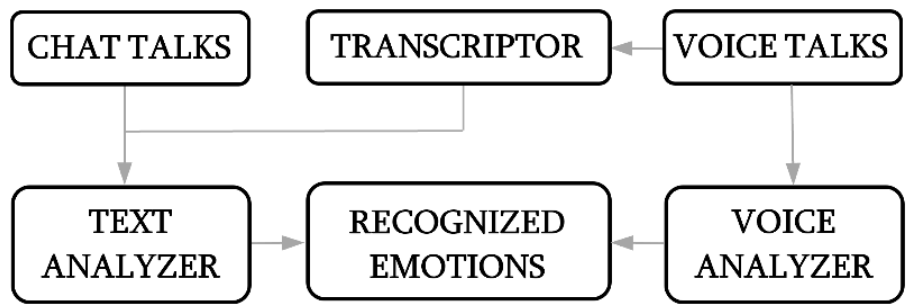
Figure 3. High level flowchart for emotion recognition method in text and voice channels.